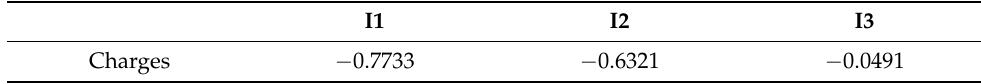
Table 7. Charges for the PCA method. I1 I2 I3